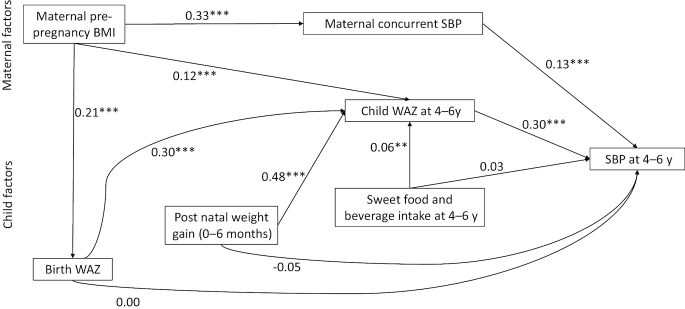
Final path model of the maternal and child factors related to child systolic blood pressure at 4–6 y. Numbers in the model are standardized β-coefficients. **P  > 0.0001 but P < 0.001; ***P < 0.0001. SBP, systolic blood pressure; WAZ, weight-for-age z score.